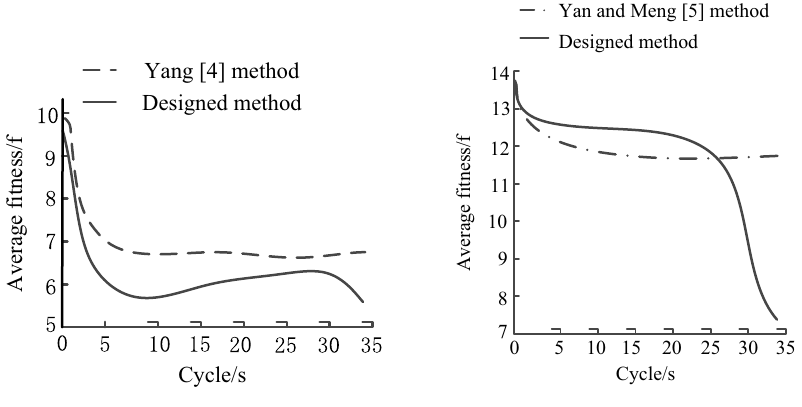
Figure 3: Performance comparison of three